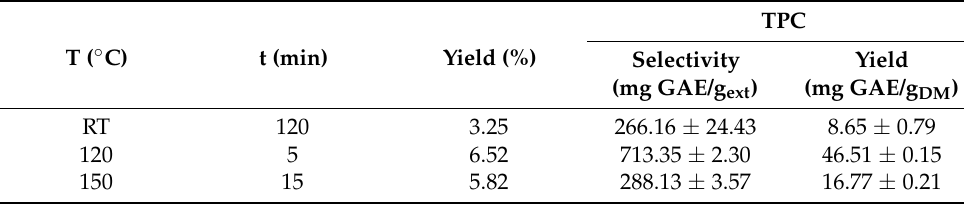
Table 3. Extraction conditions, yield, and TPC of the samples obtained with the process performed at RT, 120 ◦ C, and 150 ◦